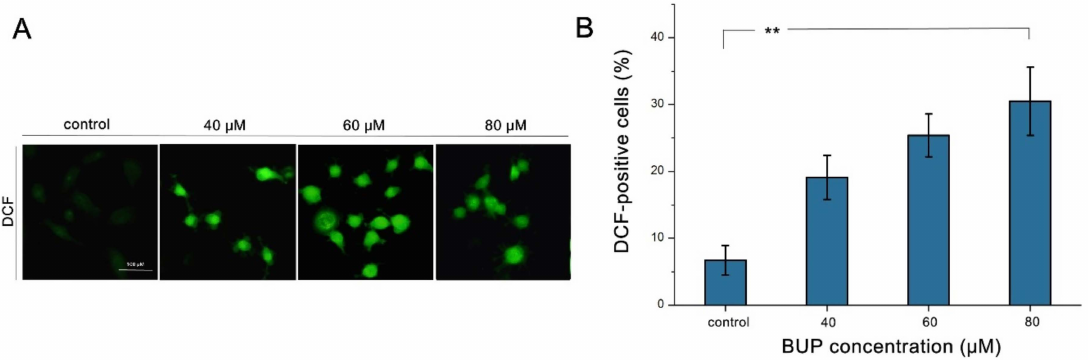
Figure 4. Analysis of ROS production in A549 cells after treatment with BUP at various concentrations, showing: ( A ) observation of DCF dyeing by epifluorescence (200 × ), ( B ) quantification of ROS levels. ** p ≤ 0.01 vs. negative control.